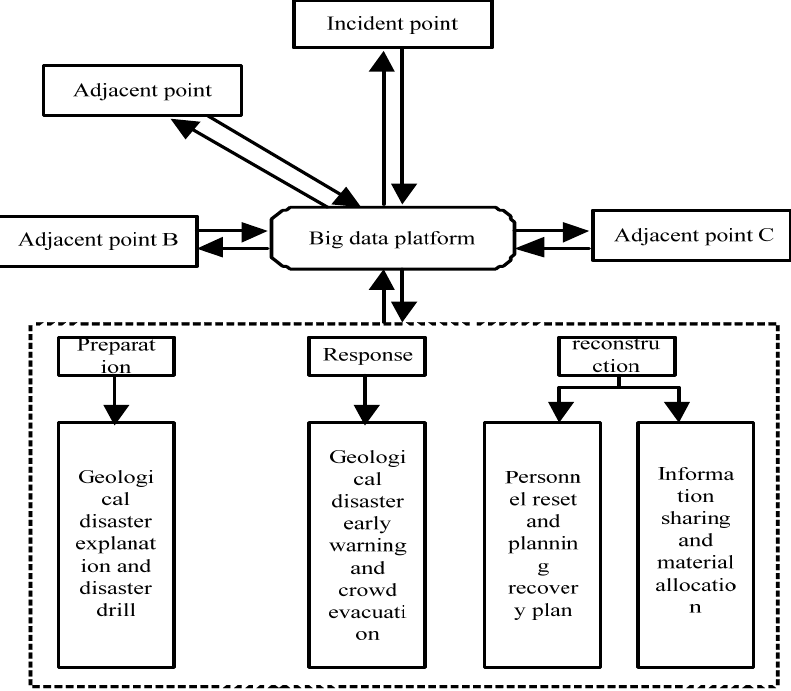
Figure 3. Emergency management system based on big data